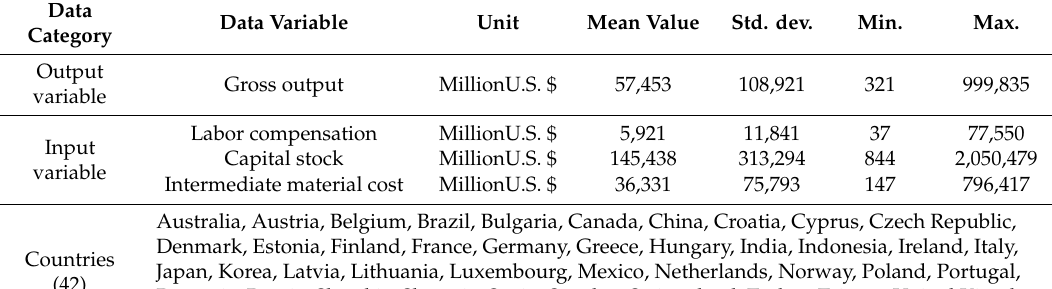
Table 1. The description of data variables for the 1st step of estimation (productivity